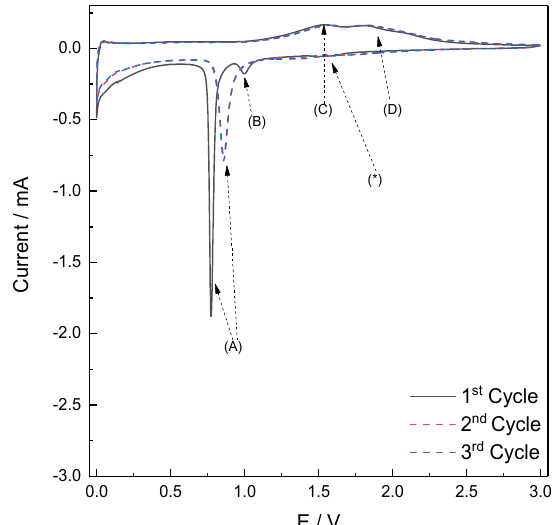
Figure 4. Cyclic voltammetry of Fe 3 O 4 /rGO performed in the potential window within 0.001 < E < 3.000 V vs. Li + /Li; scan rate = 0.1 mV s − 1 .